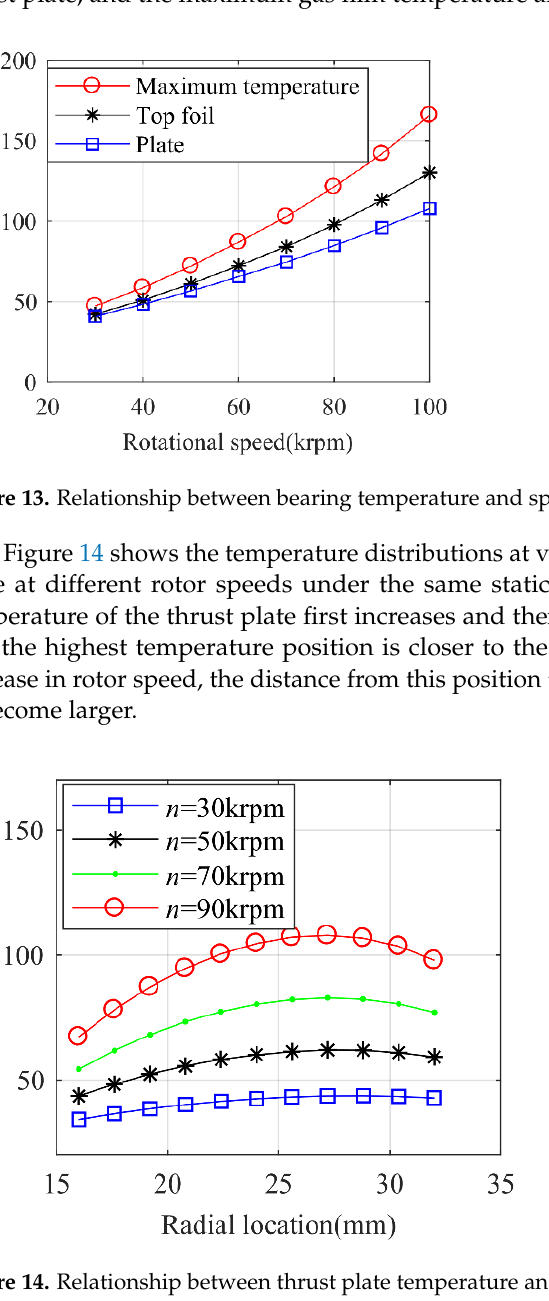
Figure 12. Relationship between bearing temperature and load.